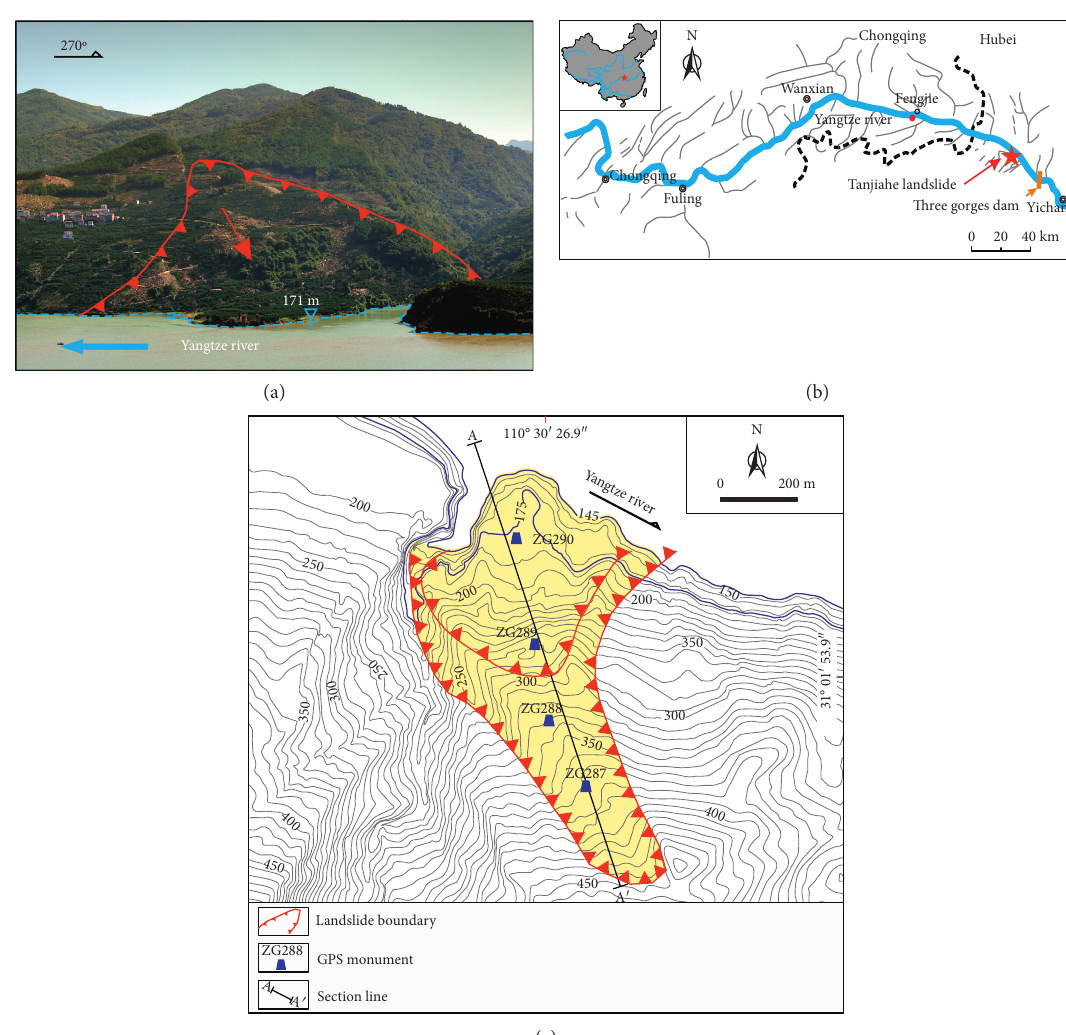
Figure 4: (a) Overall view of the Tanjiahe landslide. (b) Location of the Tanjiahe landslide, TGRA, China. (c) Topographic map of the Tanjiahe landslide.